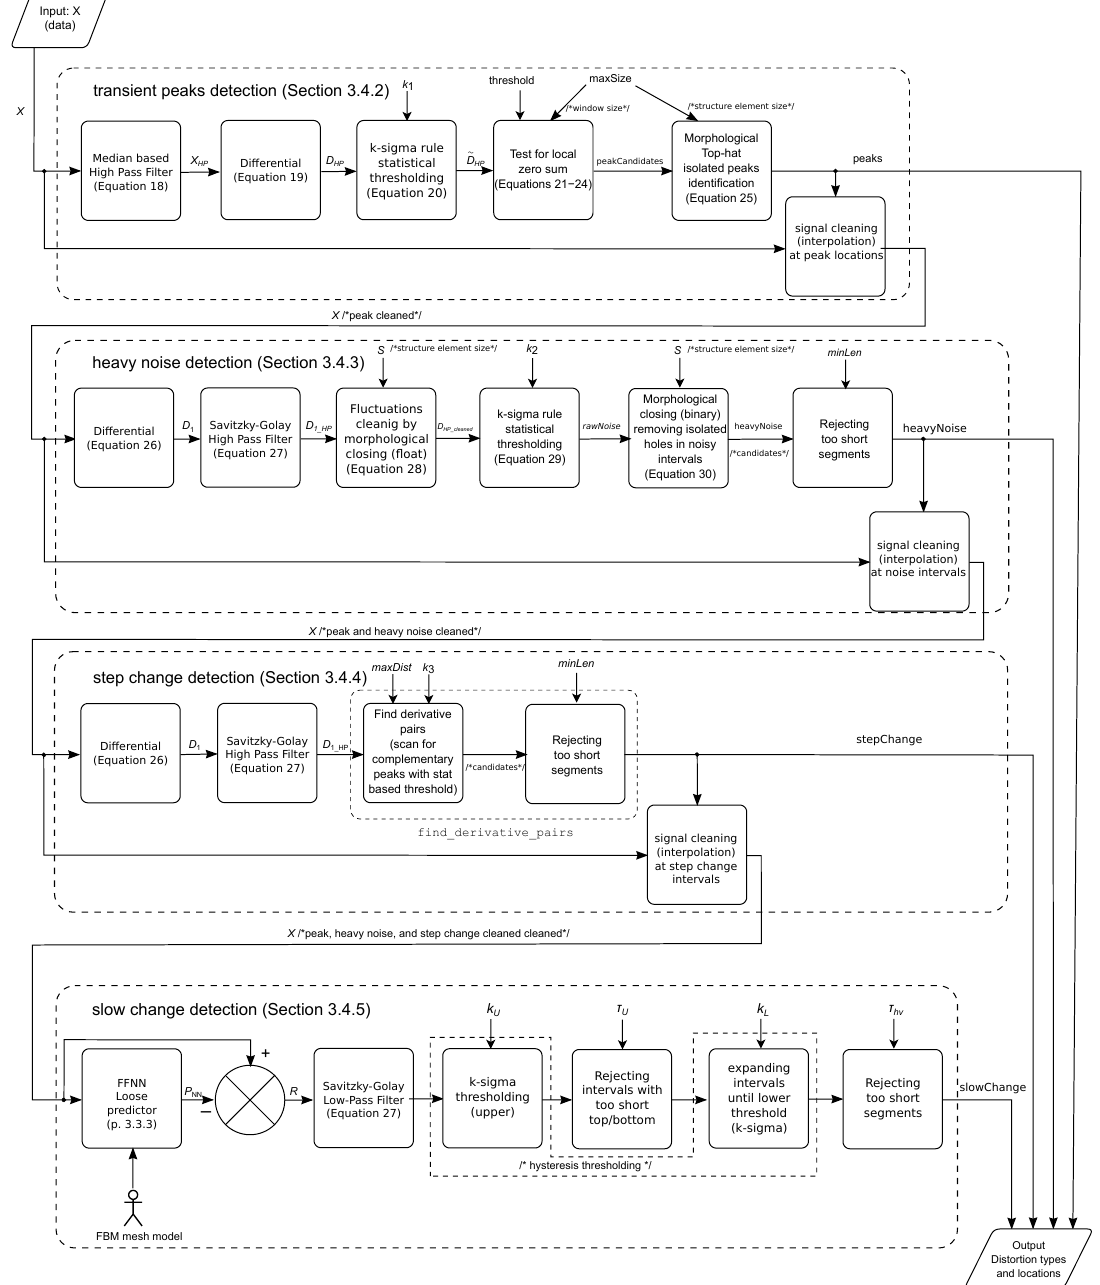
Figure 10. The detailed schematic of the proposed